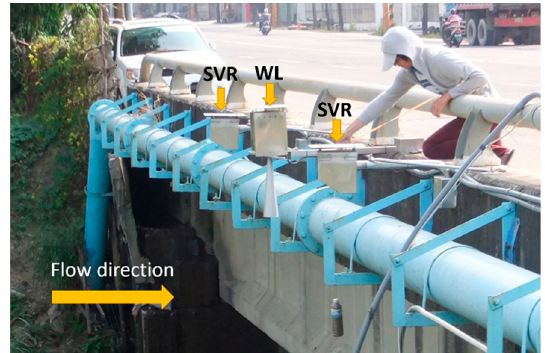
Figure 2. Photograph of the WL radar and two SVRs at Yenfong Bridge station.